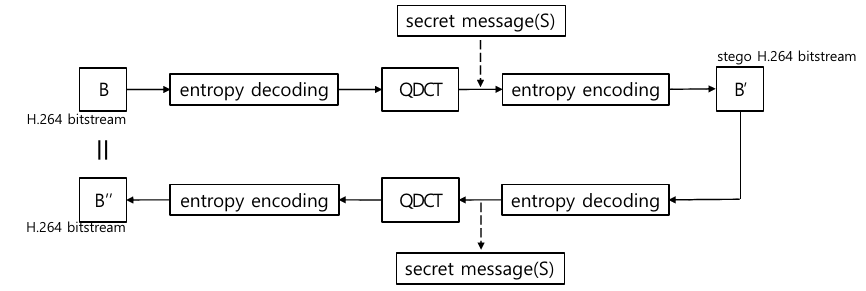
Figure 1. The overall reversible data hiding and extraction